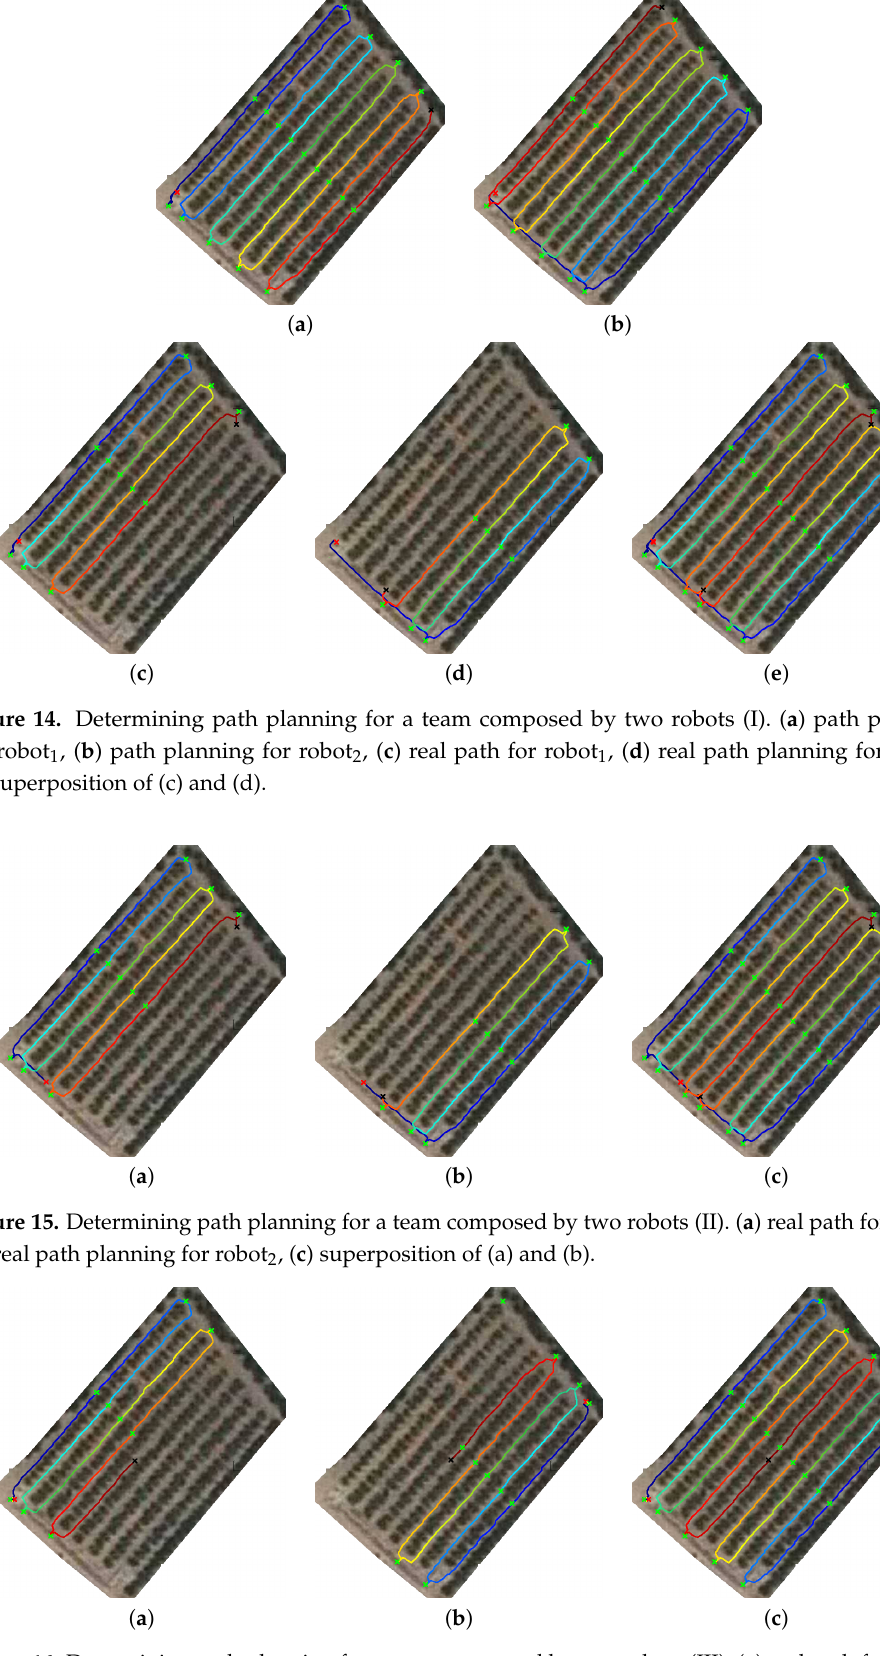
Figure 16. Determining path planning for a team composed by two robots (III). ( a ) real path for robot 1 , ( b ) real path planning for robot 2 , ( c ) superposition of (a) and